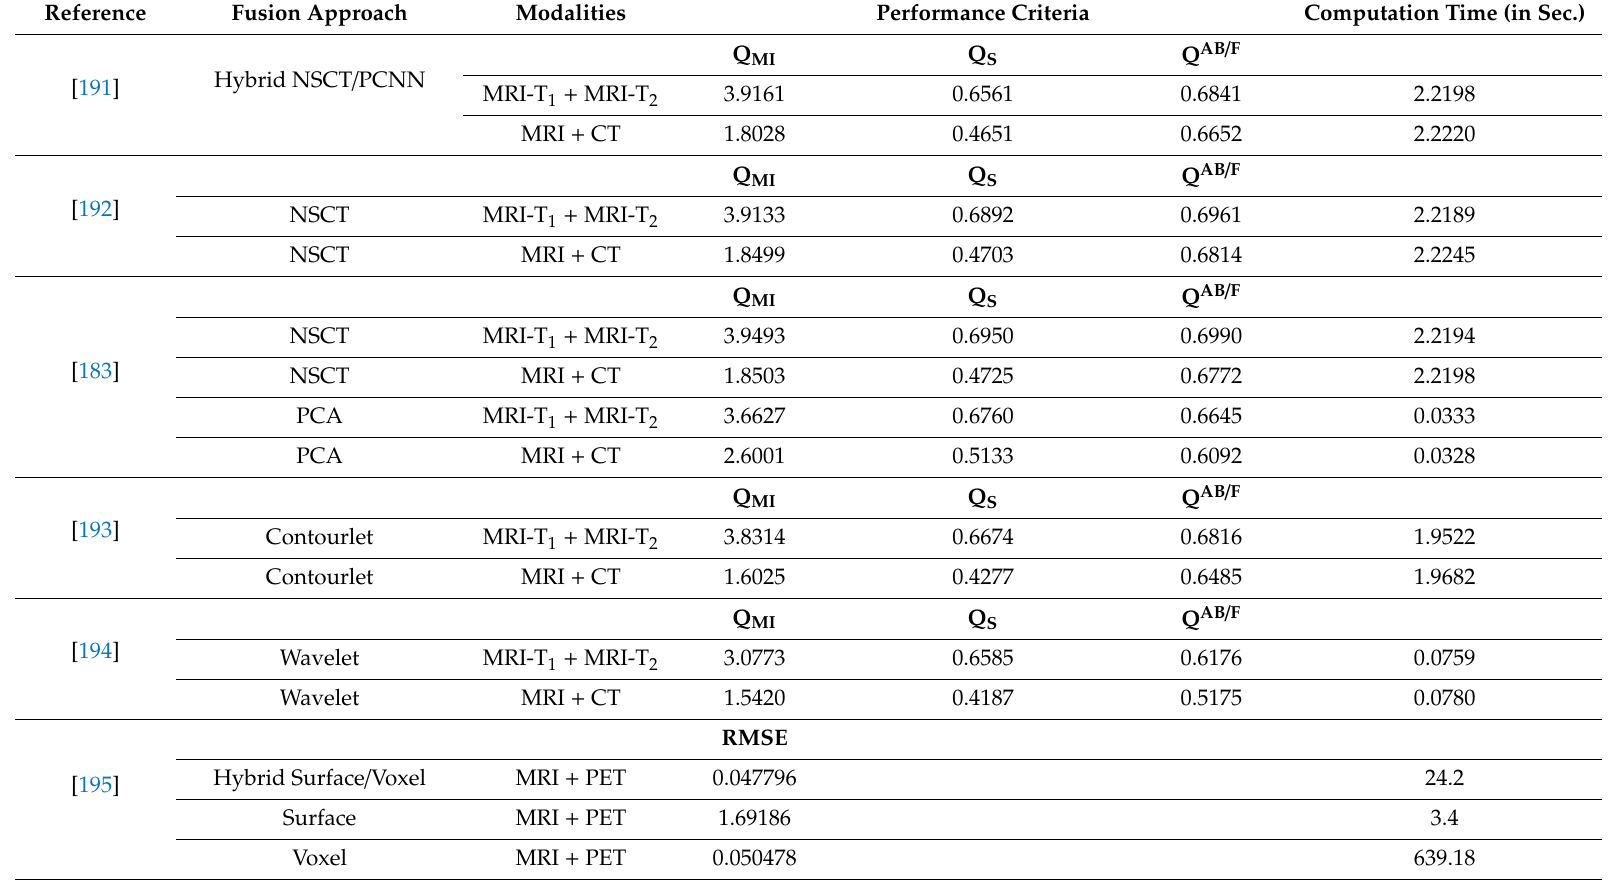
Table 4. Some works described in the literature related to the computer aided-diagnosis systems of brain diseases through multimodal fusion: The e ffi ciency of the proposed CAD system is demonstrated by experiments applying quantitative measurement parameters (penultimate column of the table) for the evaluation, and by estimating computation time in seconds for some reported works (last